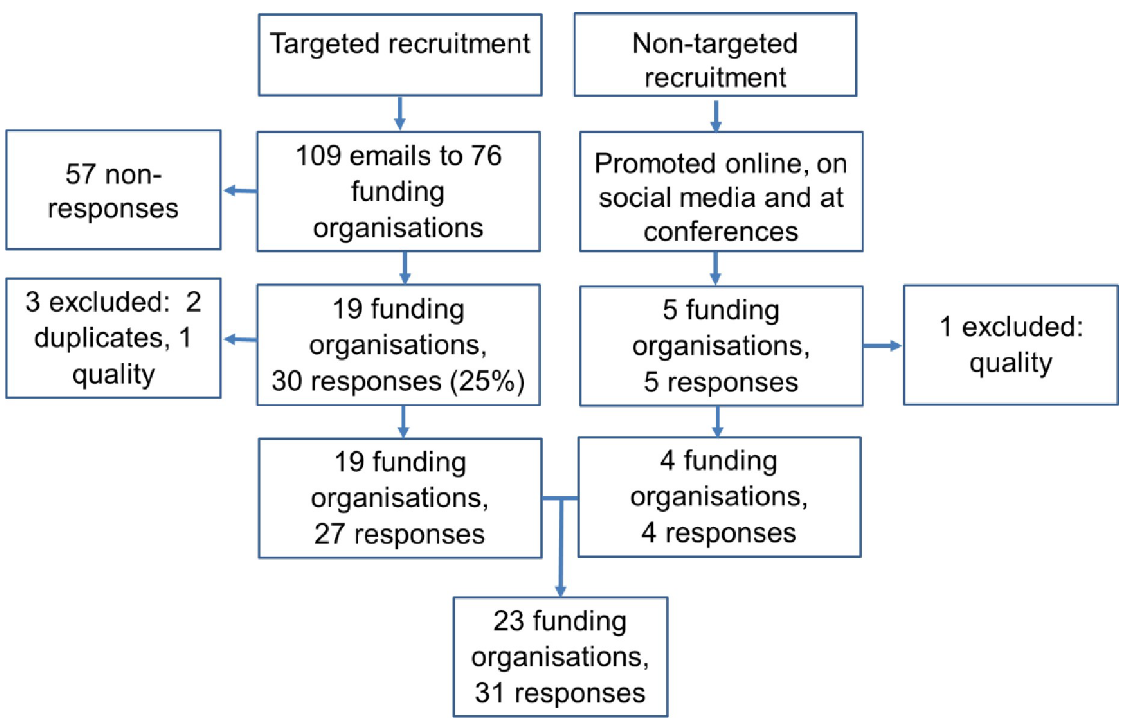
Fig 1. Diagram to show response rates. Quality = respondent identified as not being the correct person to complete the survey and did not provide complete responses. Funding organisations could provide more than one response (for different research programmes). Duplicates = There were multiple entries for a research programme. These were merged so that there was only one entry per research